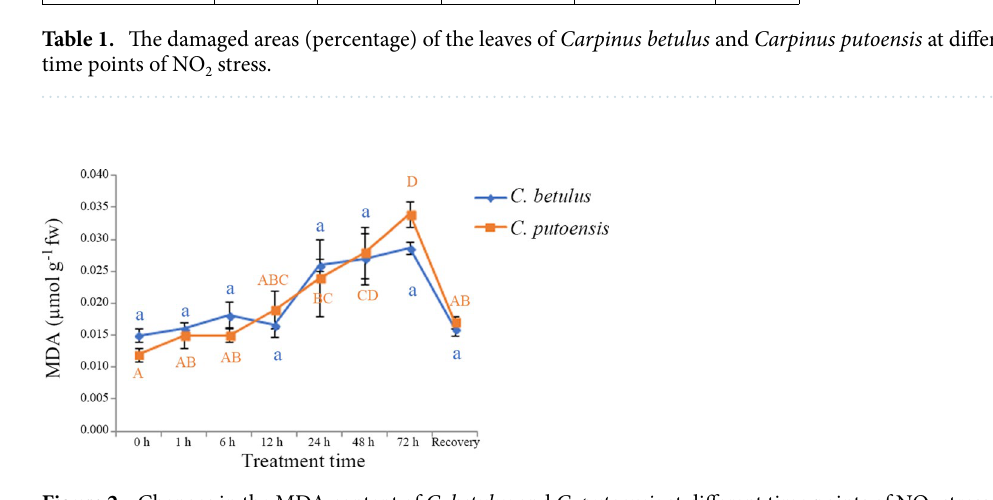
Figure 2. Changes in the MDA content of C. betulus and C. putoensis at different time points of NO 2 stress and after self recovery. Letters or letter combinations containing the same letter indicate no significant difference between the corresponding NO 2 exposure time points in the same plant species according to ANOVA or nonparametric Kruskal–Wallis ANOVA followed by Bonferroni tests. Capital letters for C. putoensis and lower letters for C.